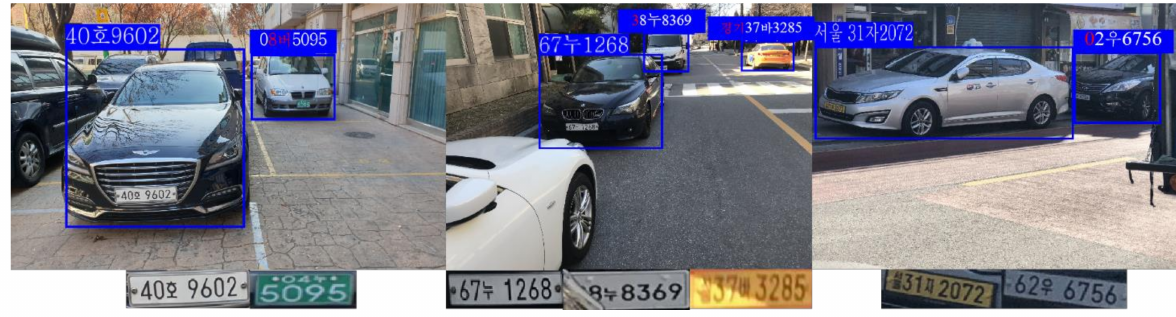
Figure 11. Some wrong recognition cases (the red characters: wrong